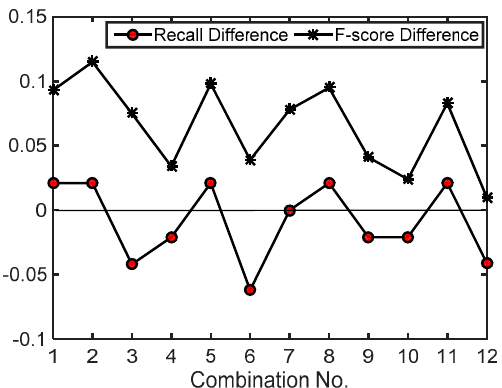
Figure 9. The effects caused by changing maxD value on test site 1. Recall (F-score) difference is the product of the recall (F-score) generated by using a maxD of 1.5 m minus the one generated by using a maxD of 1.0 m. The parameter values for each combination can be found in Table 2. Significance level = 0.10. For maxD = 1.0 m, score threshold = 5.5. For maxD = 1.5 m, score threshold =